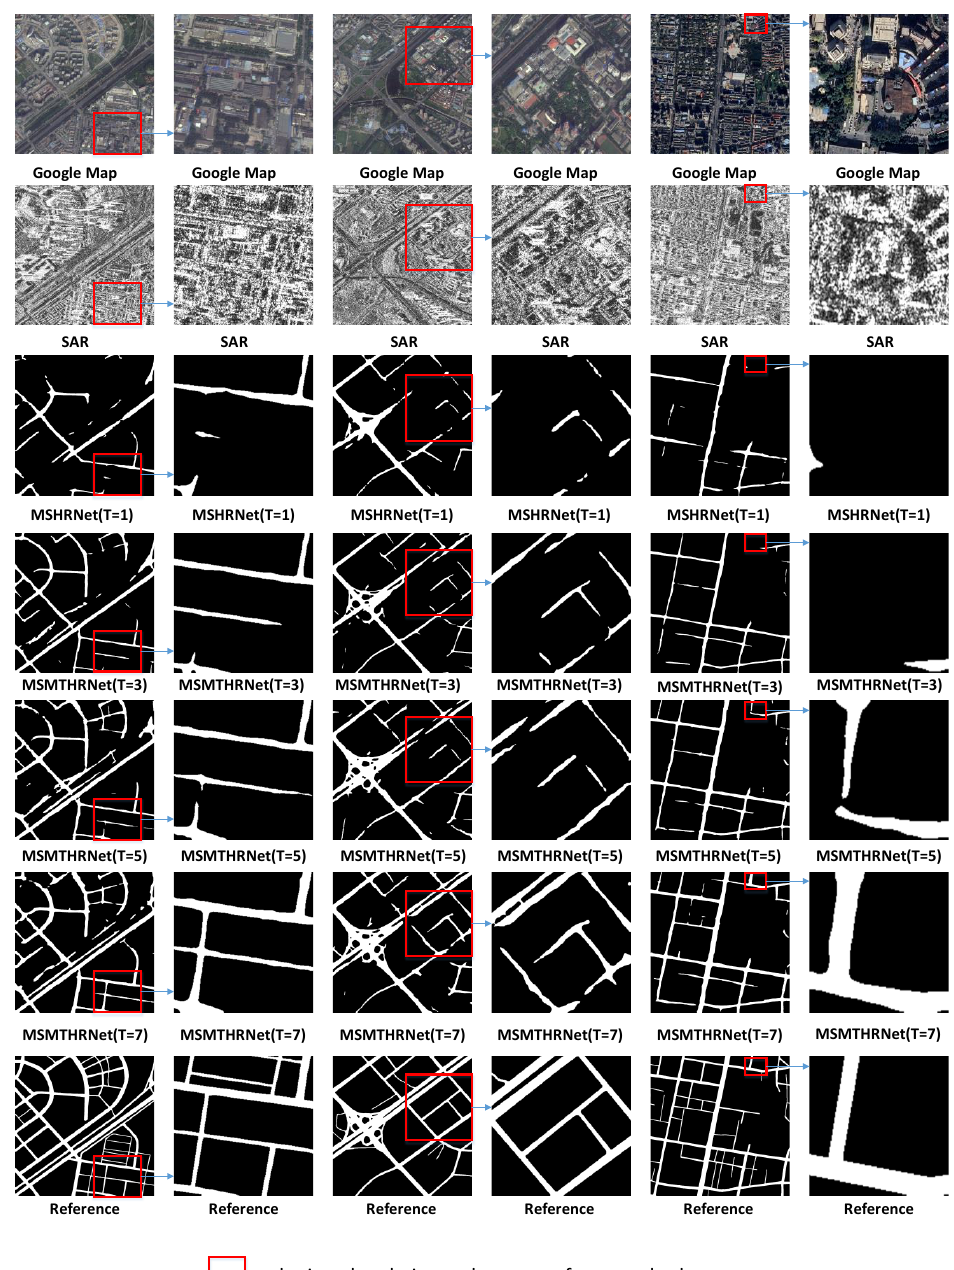
Figure 11. Qualitative comparison of road detection results produced by different methods based on three images from our test